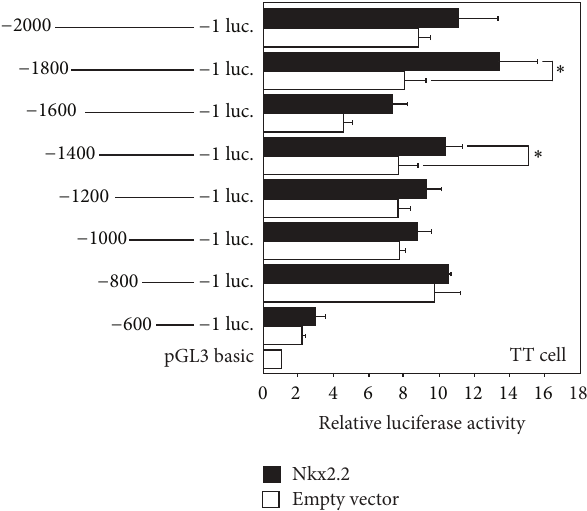
Figure 7: Ghrelin promoter activity by Nkx2.2. Schematic diagram representing deletion of the human ghrelin promoter introduced into the upstream of the firefly luciferase gene. Promoter activity was normalized to Renilla luciferase activity. The data represent the mean ± SE for triplicate samples. Asterisks indicate the differences between each group ( 𝑃 < 0.05